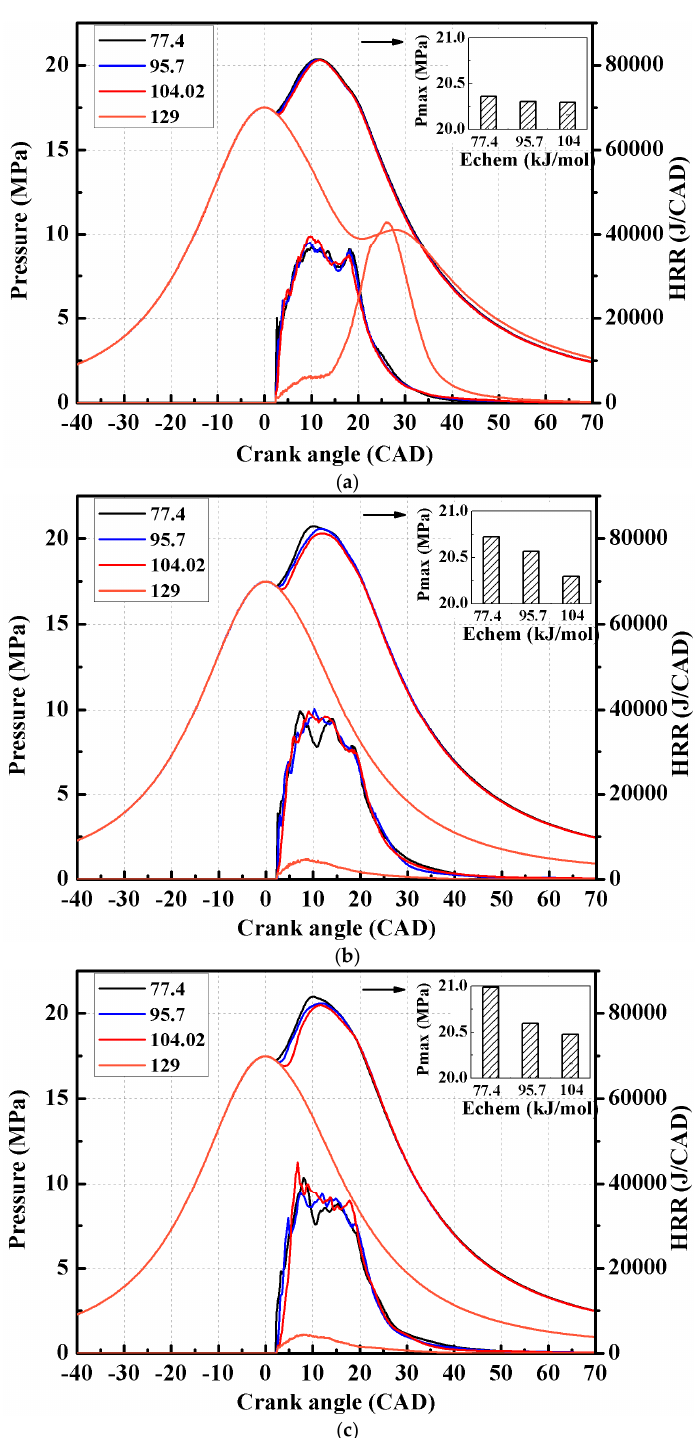
Figure 10. Combustion performance of marine engine fueled with HFO at different engine